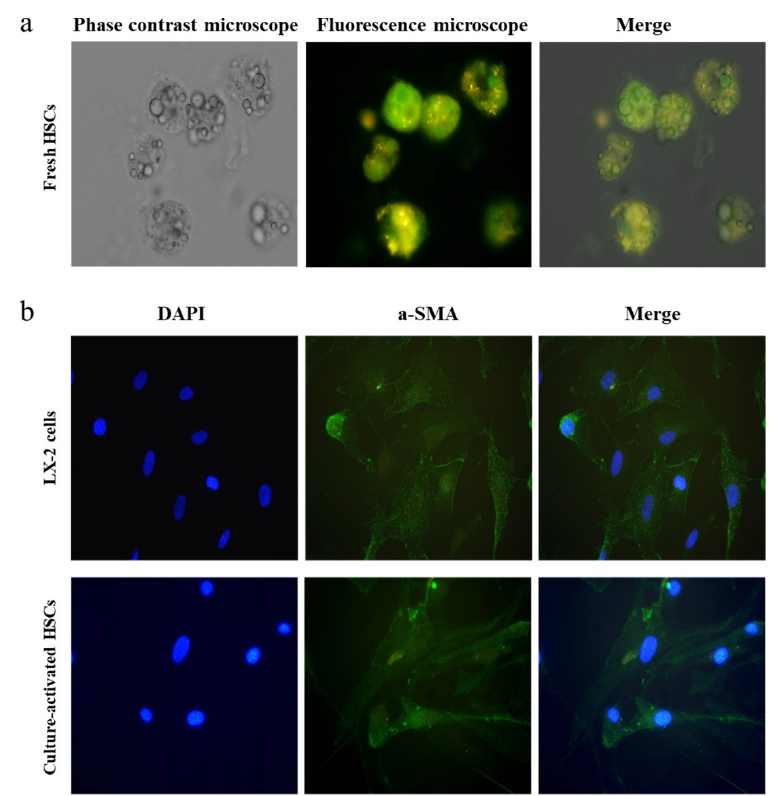
Figure 2. Identification of HSCs isolated from human liver tissues. ( a ) Autofluorescence of cytoplas- mic vitamin A in freshly isolated HSCs. ( b ) Immunofluorescence staining of culture-activated HSCs and LX-2 cells for α -SMA (magnification: 400 × ; in ( a , b )). α -smooth muscle actin, α -SMA; hepatic stellate cells,